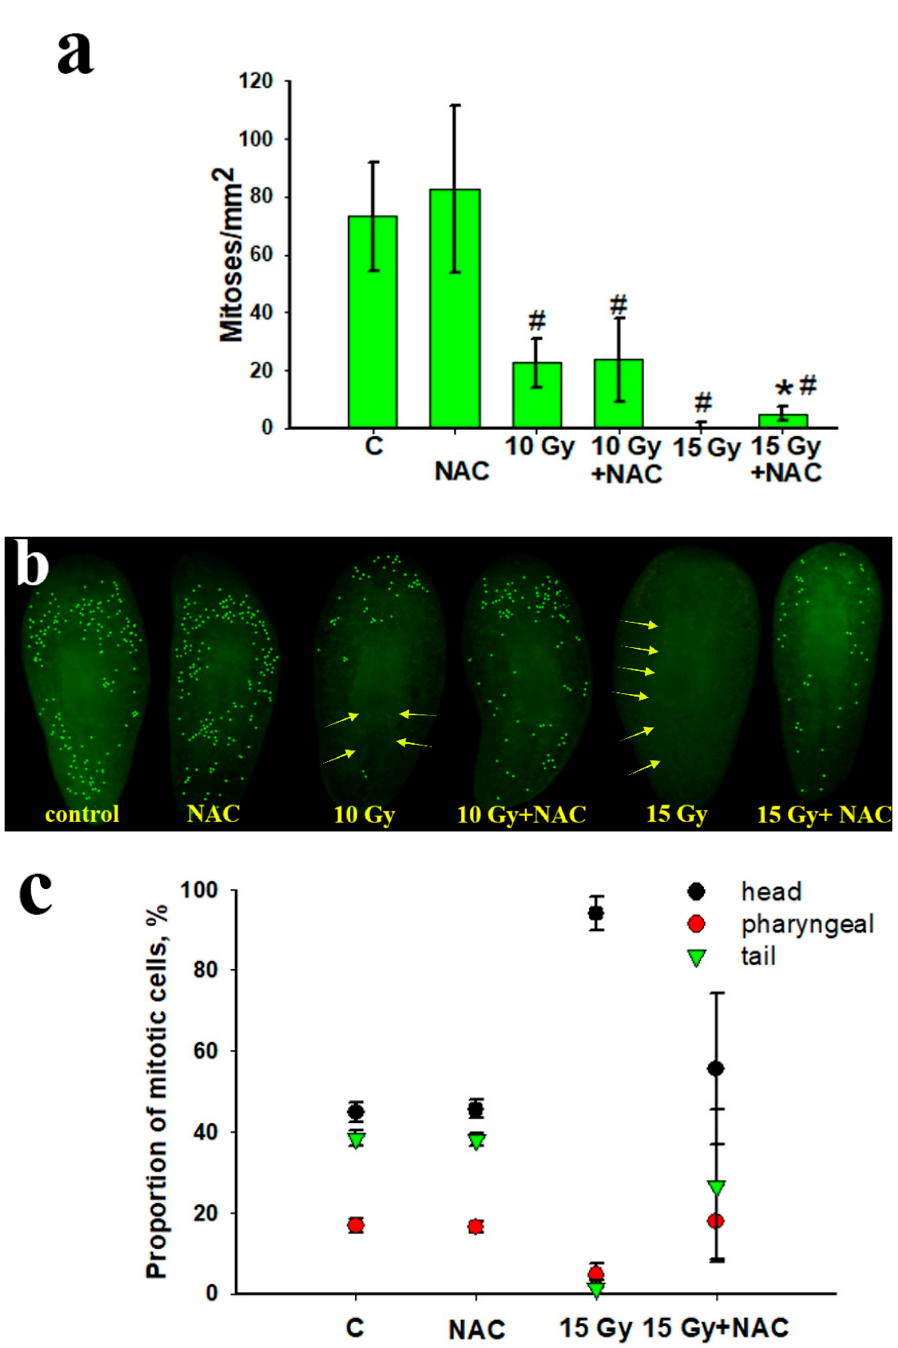
Figure 3. Number of mitotic cells in the planarian body 7 days after X-ray irradiation (10 and 15 Gy) with NAC (10 mM). ( a , b ) Determination of the total number of mitotic cells in the planarian body stained by immunohistochemistry; ( c ) distribution of mitotic cells in the planarian body 10 days after irradiation at a dose of 15 Gy. # p < 0.001 (from control), * p < 0.001 (from 15 Gy). Arrows indicate the absence of mitotic cells after X-ray